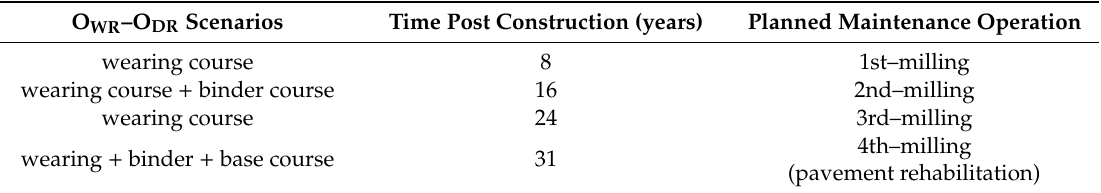
Table 6. Maintenance and planned operations of open-graded